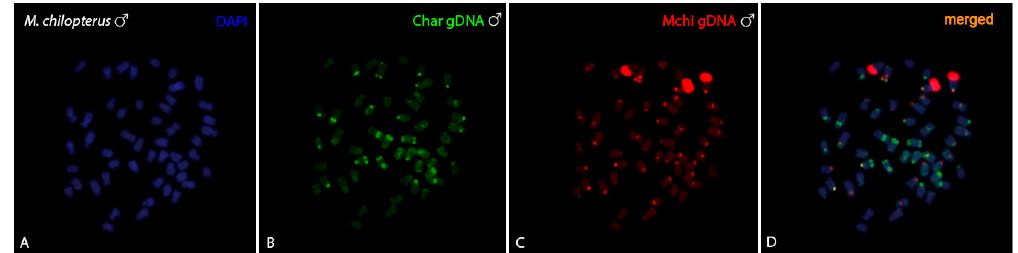
Figure 7. Comparative genomic hybridization (CGH) for interspecific comparisons. Male-derived genomic probes from Cosmochilus harmandi (Char—green) and Mystacoleucus chilopterus (Mchi—red) hybridized together onto male chromosomes of M. chilopterus ( A – D ). The common genomic regions are depicted in yellow on the last column ( D ).